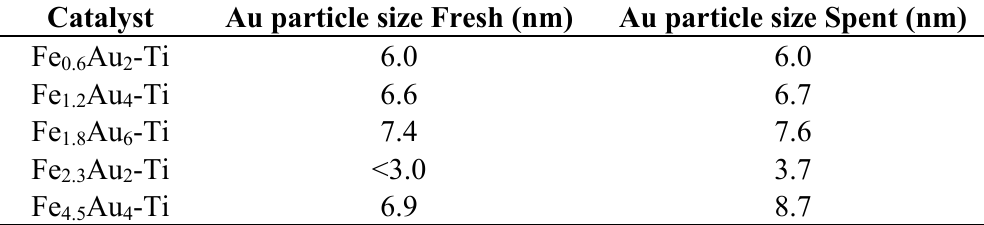
-Ti and Au-FeO -Ce x x